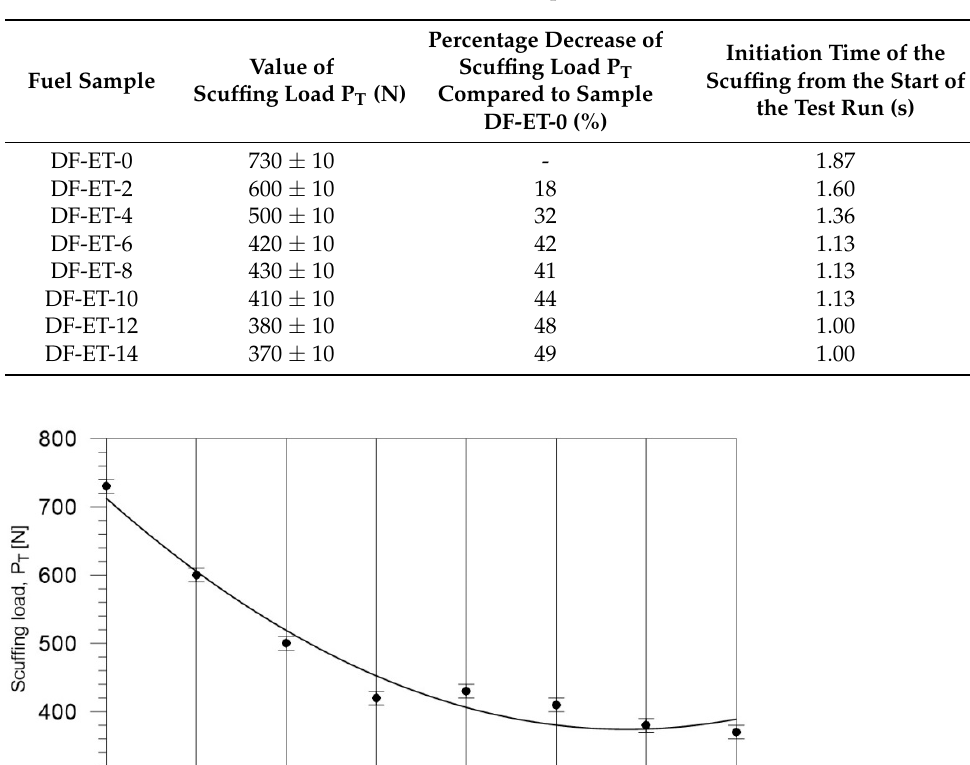
Table 5. Lubrication test results for individual fuel samples.